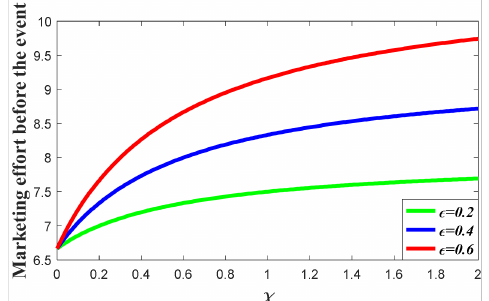
Figure 2. Impacts of ε on marketing decision.